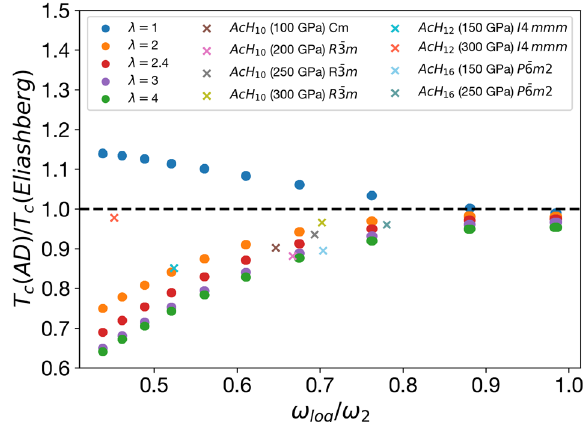
Fig. 4 Ratio of the Allen – Dynes and Eliashberg T c for a bimodal Einstein-like model compared to data for hydrides. The hydride data are obtained from refs. 35 – 37 . For the bimodal spectral functions, we select λ 1 = λ 2 for simplicity and vary the total λ from 1 to